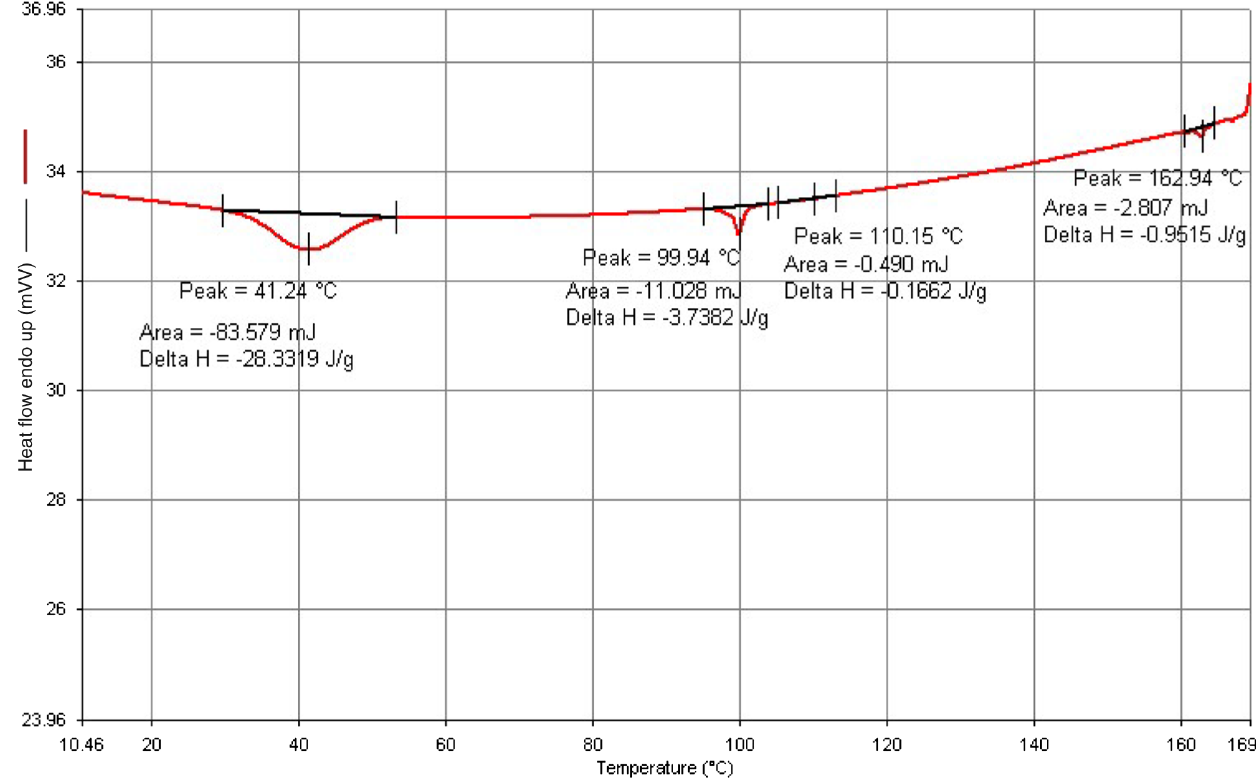
FIG. 14. DSC scan on cooling of the